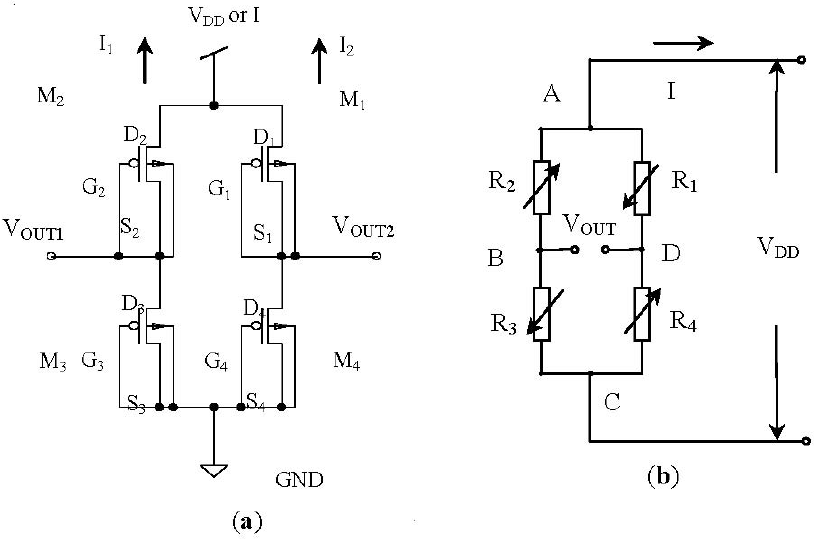
Figure 3. Operation principle of the nc-Si/c-Si heterojunction MOSFETs pressure sensor. ( a ) Wheatstone bridge; ( b ) Equivalent